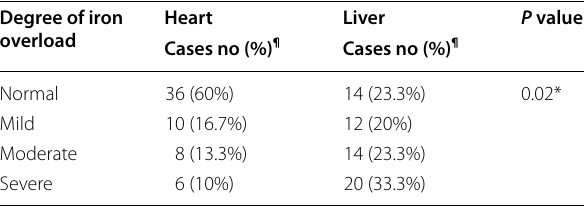
Table 3 Association between certain variables and